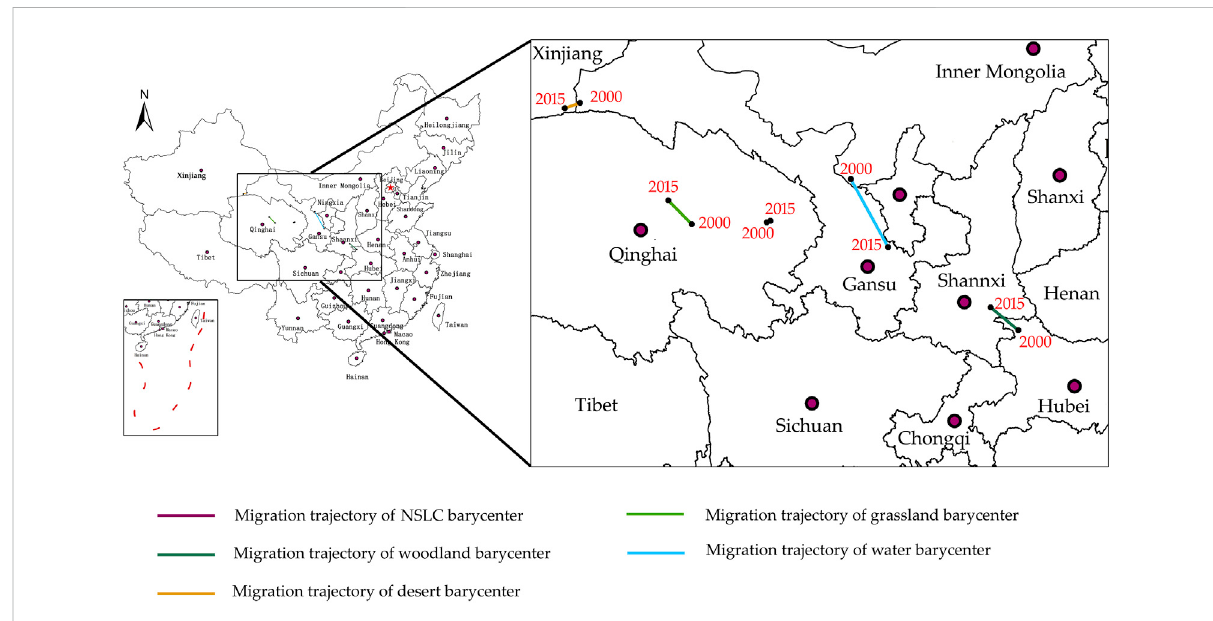
FIGURE 8 Migration trajectory of ecological space baryleft from 2000 to